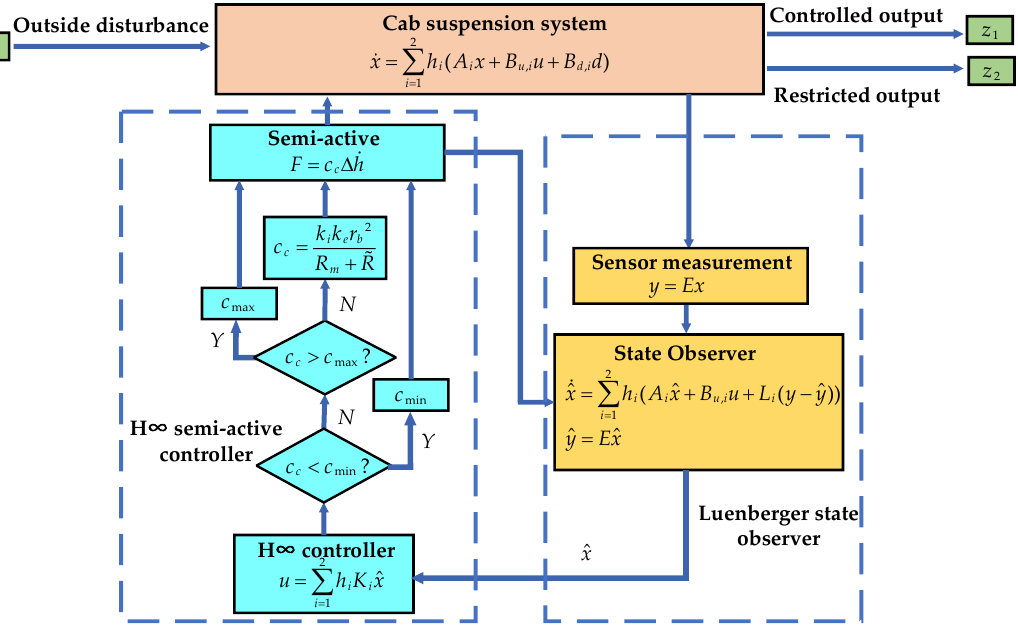
Figure 9. The process of control and observation.